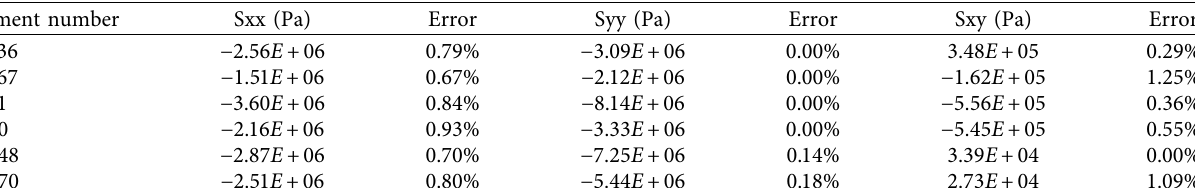
Table 6: The calculated stress in measured points by the reduced order